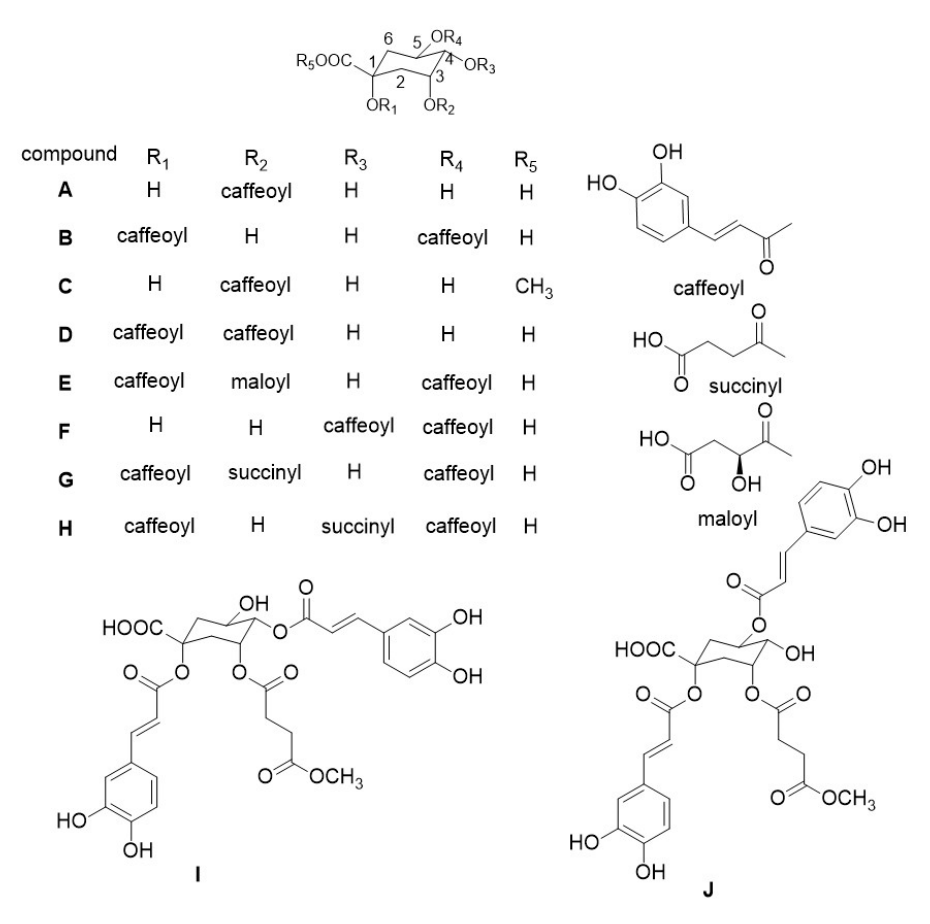
Figure 1. Chemical structures of ten caffeoylquinic acid derivatives from burdock roots.